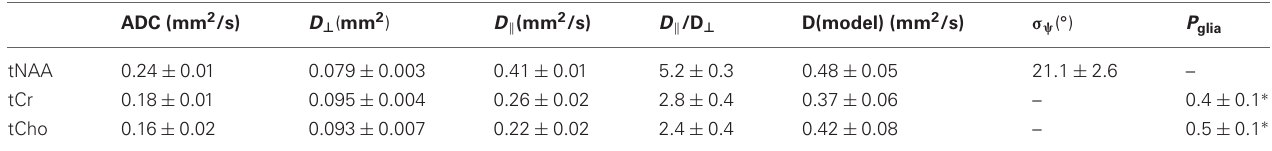
Table 1 | Group-averaged DWS data ( n = 6 for tNAA and n = 6 for tCr and tCho) for the three metabolites.